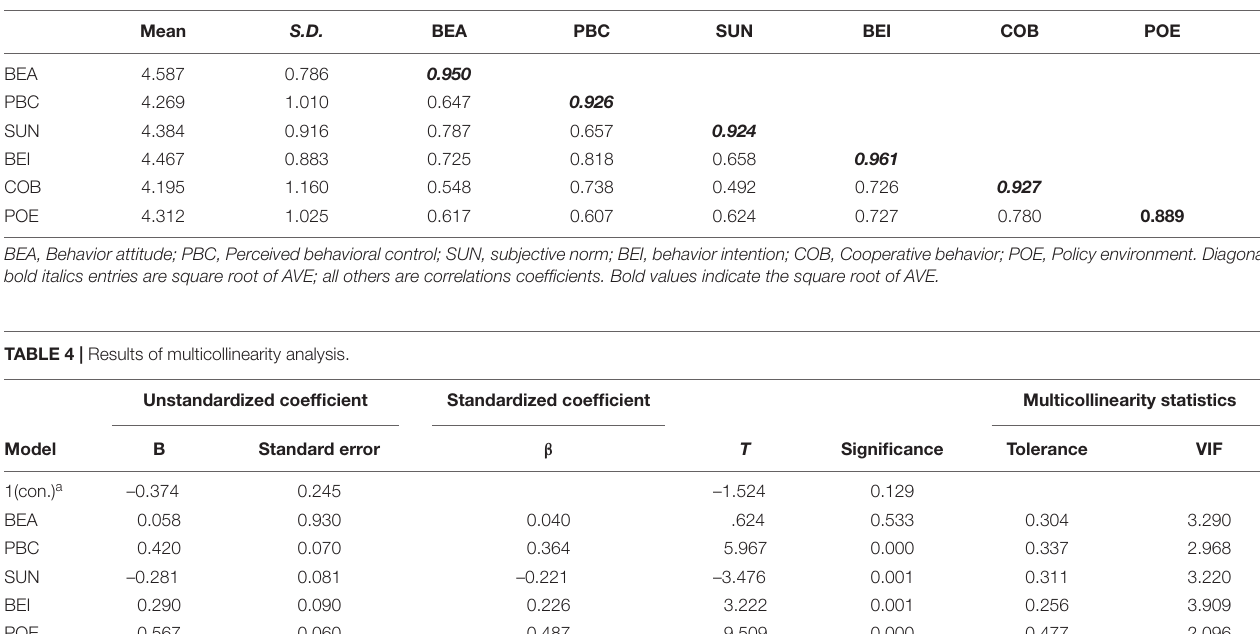
TABLE 3 | Results of discriminant validity testing.